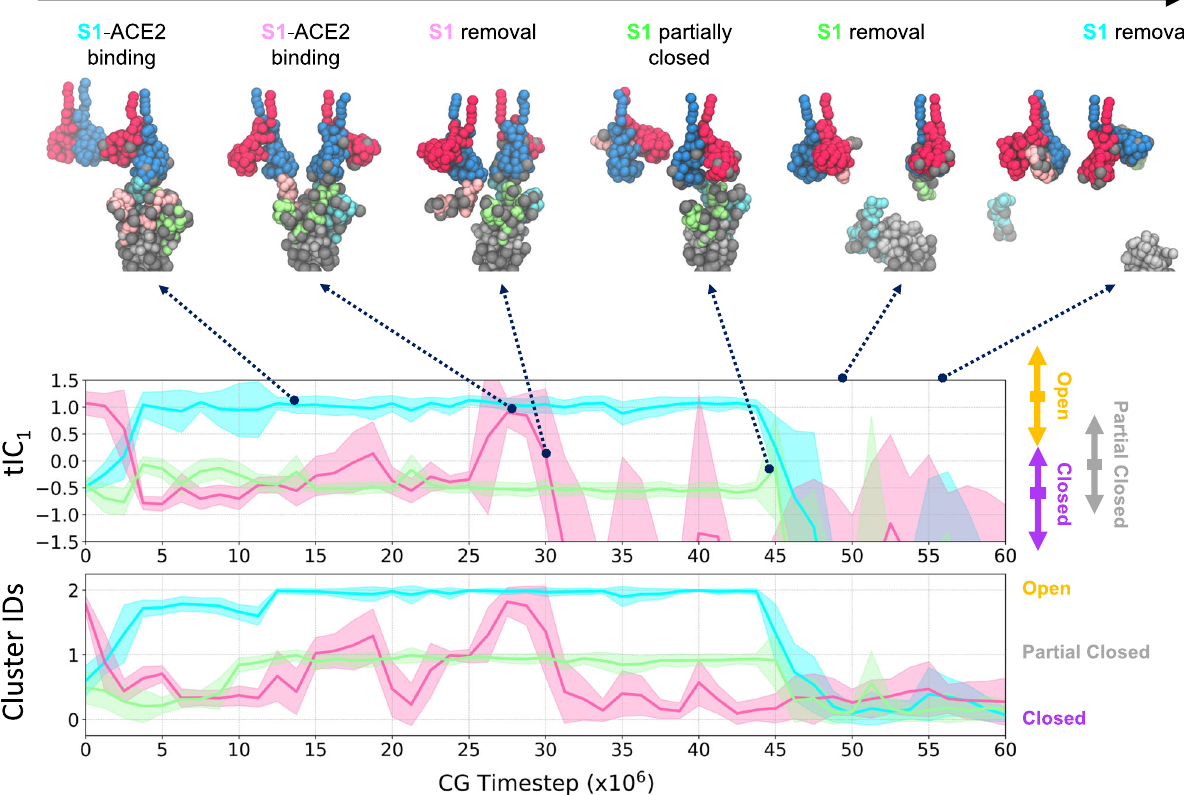
Fig. 2 Dissociation of S1 facilitated by multivalent ACE2 binding. (Top) Snapshots of one representative S1 dissociation process upon binding of two ACE2 dimers. Each monomer in the ACE2 dimer is represented by red and blue beads, respectively, while each S1 protomer in the spike trimer is represented by cyan, pink, and green beads, respectively. The gray and silver beads denote glycans and S2 protomers, respectively. The depicted process is also shown in Supplementary Movie 1. (Middle) Time series pro fi le depicting tIC 1 evaluated for the RBD of each protomer (sharing the same color) for the spike trimer depicted above, i.e., spike trimer protomers are labeled cyan to pink to green (back to cyan) in counter-clockwise order when viewing from the top-down. To the right of the panel, the double-ended arrows represent the extent of the tIC 1 distributions for each state from Fig. 1b, while the rectangle shows the peak of each distribution. (Bottom) Time series pro fi le depicting k-means cluster IDs for the RBD of each protomer (same color scheme as the middle panel). To the right of the panel, the structural class assigned to each cluster ID is annotated. Each time series pro fi le depicts the mean (line) and standard deviation (shaded region) of N = 25000 points using block averaging over 500 points.